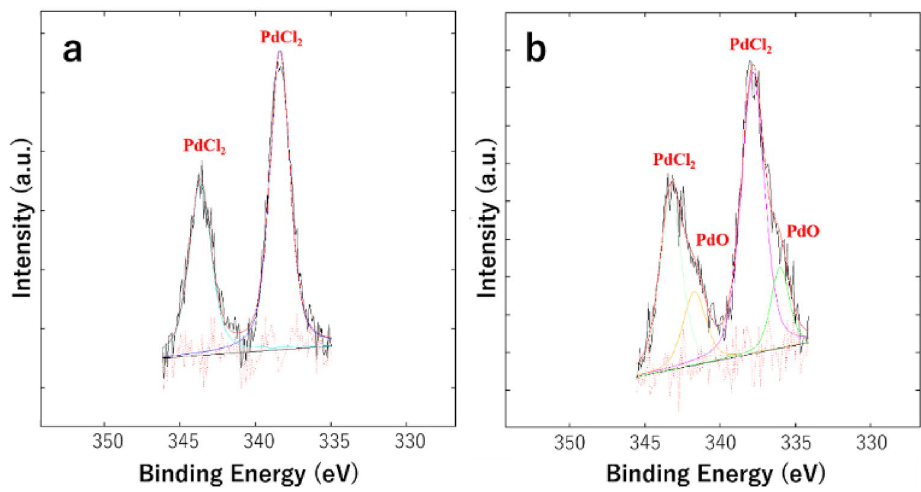
Figure 4. XPS analysis of MNPs@SiO 2 -NH 2 @Pd(dpa)Cl 2 artificial metalloenzyme before ( a ), and after ( b ), reaction